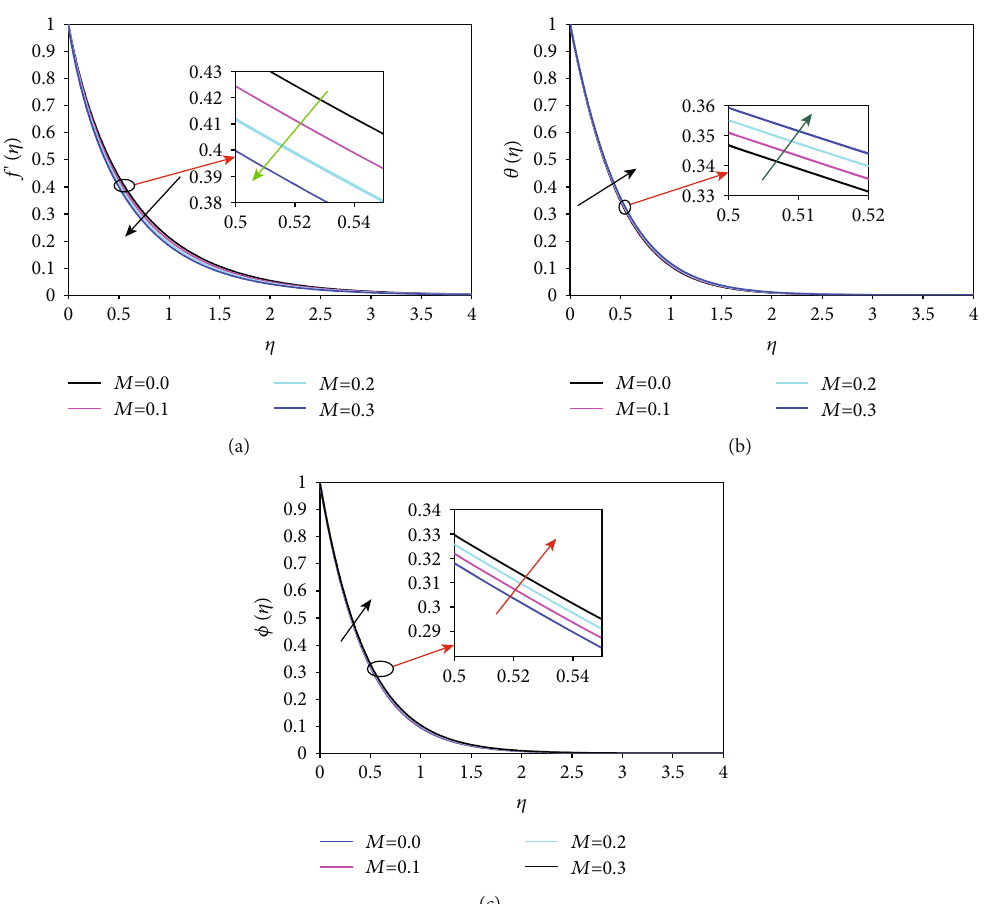
Figure 5: The graph of velocity, temperature, and concentration for di ff erent values of magnetic fi eld ( M